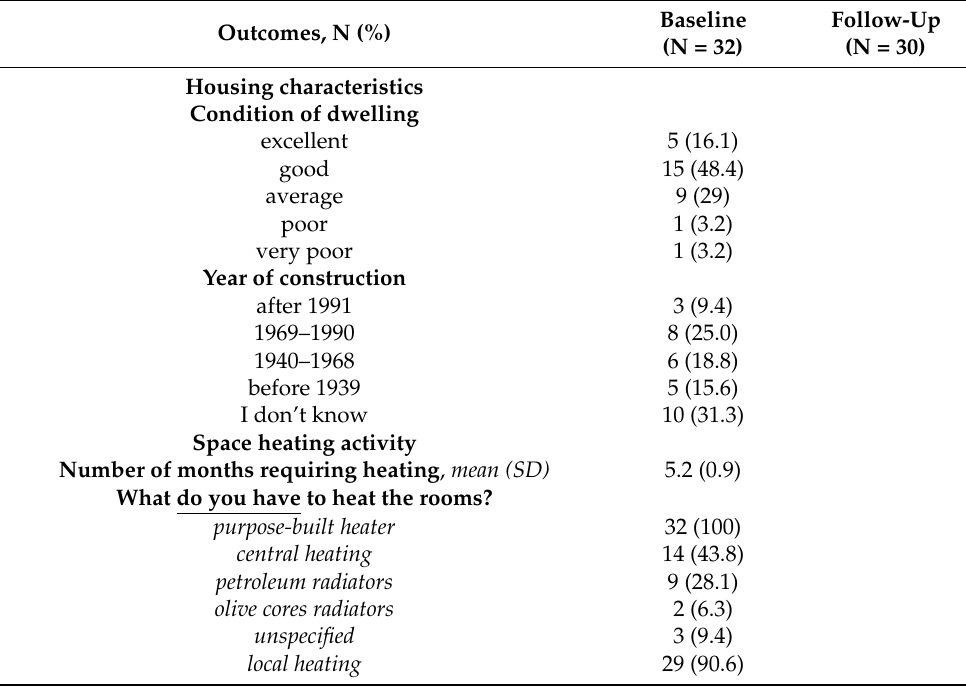
Table 1. Household conditions, heating activity and air pollution sources at baseline and follow-up in rural Crete,